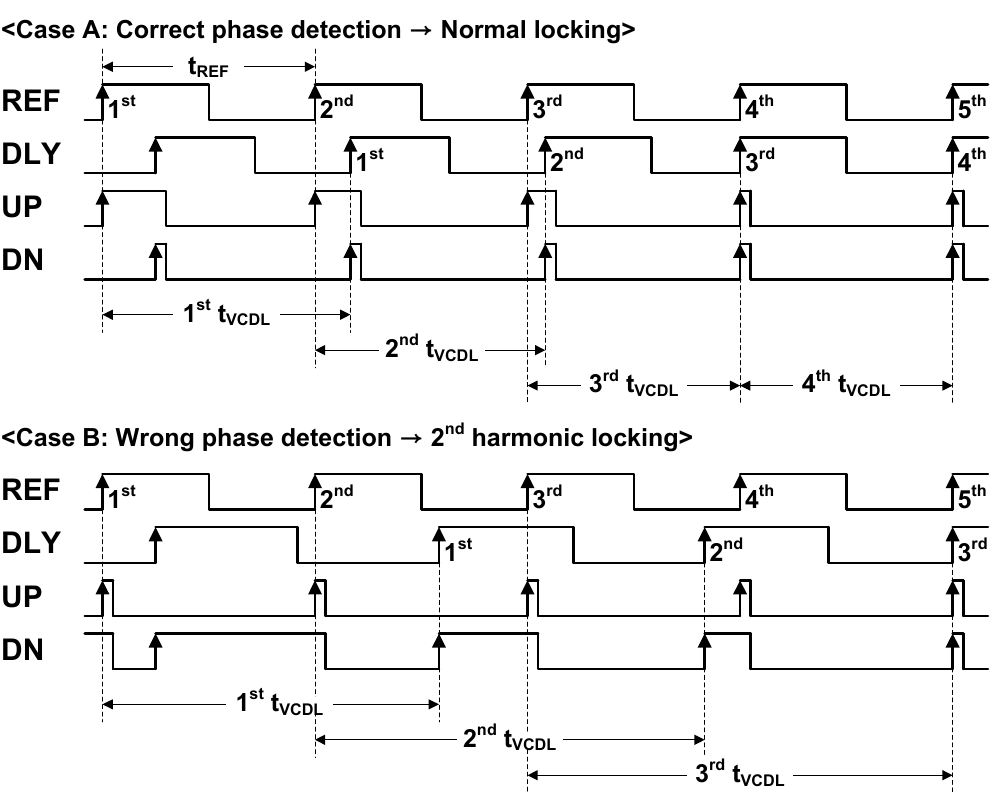
Figure 2. Two different operations of conventional PD under the same input condition as 1st t VCDL > t REF (Case A: Correct phase detection; Case B: Wrong phase detection).